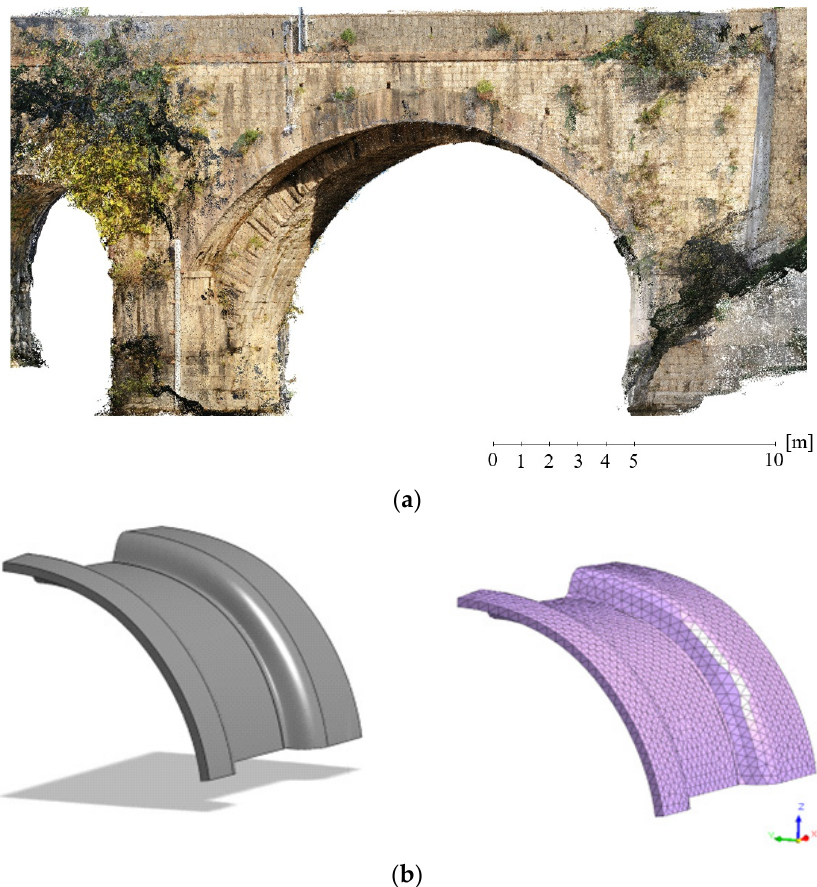
Figure 11. Masonry bridge from Roman times incorporated into a bridge from the 1800s and located in South of Italy: image of step acquisition ( a ) and FEM model of the arches of the bridge ( b ). A widely used 2D approach from orthophotos concerns the construction of 2D CAD drawings that are particularly useful in the fields of archaeology and architecture [136]. An architectural application was realised for the construction of a CAD representation of the staircase of the church of San Domenico in Taranto (Italy), as shown in Figure 12.